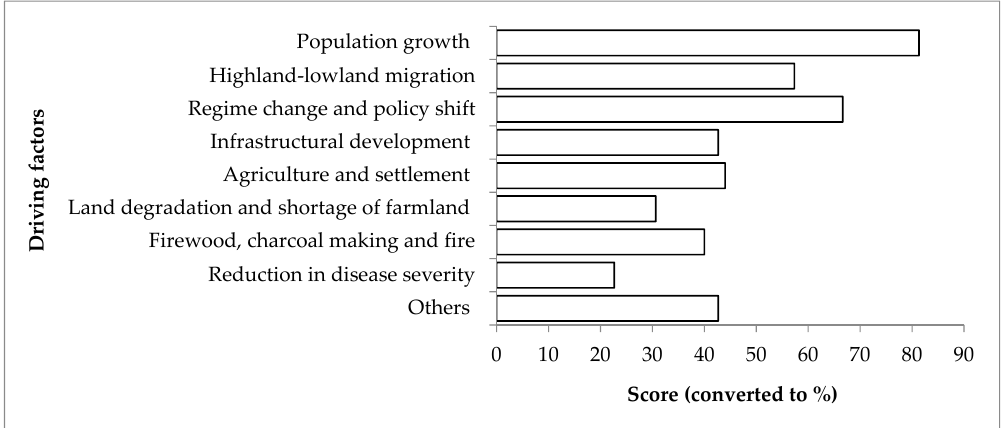
Figure 2. Drivers of LULC changes between 1985 and 2010 in ACB.